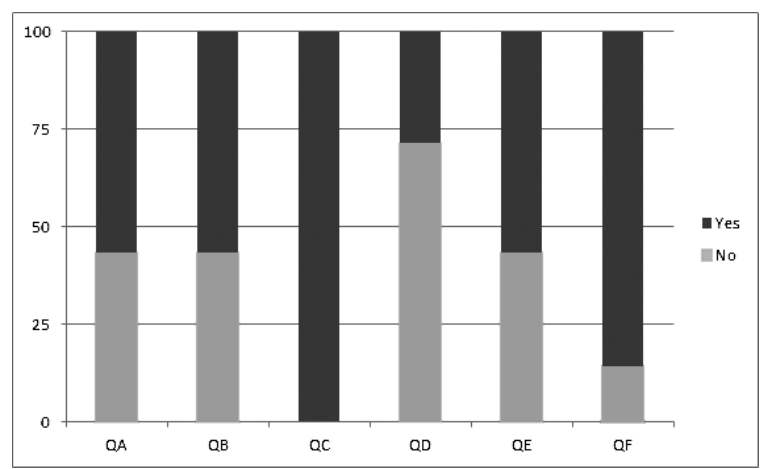
Figure 6. Conducted survey polling eight people at the restaurants. Results for the questions QA–QF in